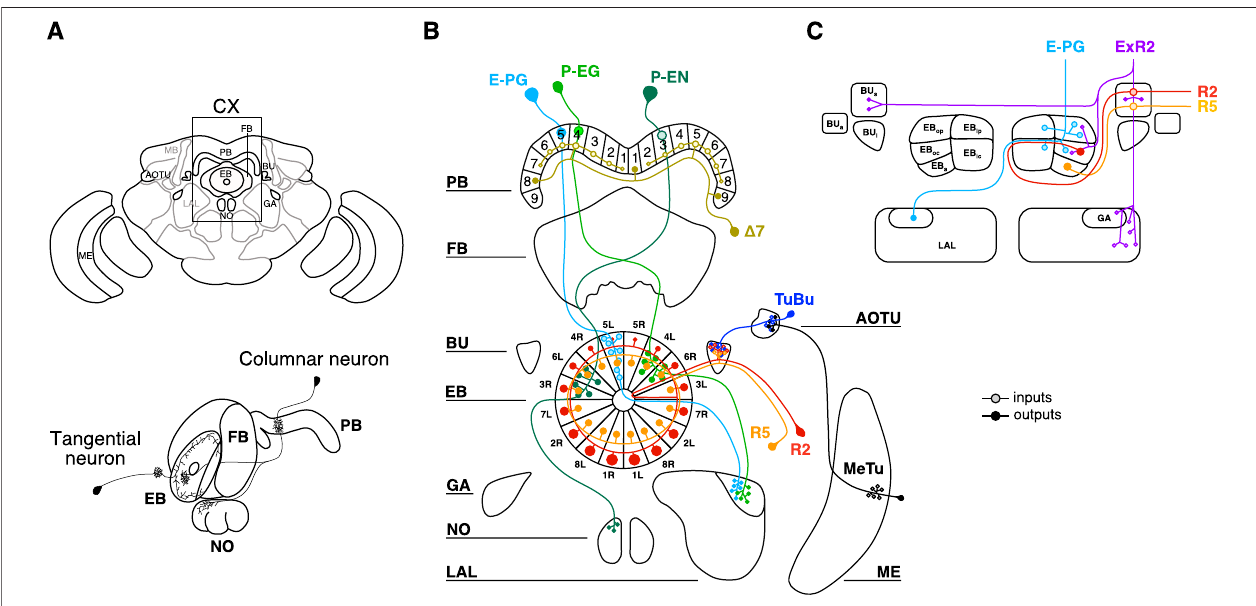
FIGURE 1 | Central complex and type of neurons innervating the ellipsoid body. (A) On the top, cartoon of the fl y brain with a window framing the central complex (CX). Four different neuropils composed the CX: protocerebral bridge (PB); fan-shaped body (FB); ellipsoid body (EB) and noduli (NO). Other brain regions represent important hubs for the information transmitted to/from the CX: medulla (ME); anterior optic tubercle (AOTU); bulb (BU); gall (GA) and lateral accessory lobe (LAL). On the bottom, example of two different types of neurons innervating the CX: tangential and columnar neurons. (B) Circuit diagram of the columnar neurons involved in encoding the visual inputs and in translating them to information for navigation and goal-oriented behaviors. E-PG neurons are columnar neurons receiving inputs in the EB and sending outputstoPBand GA.P-EG and P-EN arecolumnar neurons receiving inputs in thePBand sending outputs totheEB. Δ 7neuronsreceiveinputs from seven glomeruli in the PB and send output to three glomeruli spaced out by seven glomeruli. R2 and R5 are tangential neurons innervating similar regions of the EB and BU. MeTu neurons, relaying visual information to the AOTU, are also depicted. (C) EB domains innervated by the neurons object of our study: E-PG, R2 and R5. ExR2 (also known as PPM-EB) dopaminergic neurons are also depicted (image adapted from Omoto et al., 2018).